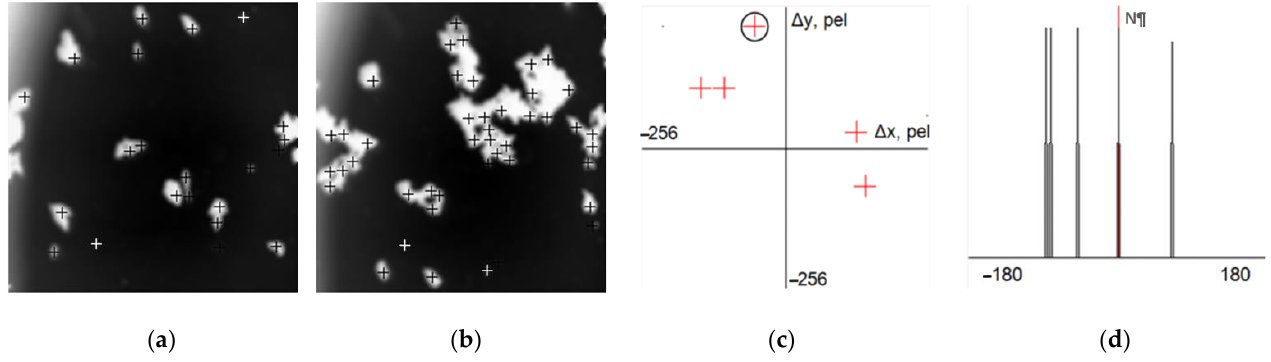
Figure 8. Results obtained by the IMBKPP method for the copper microparticles’ images: ( a , b ) source images with marked particle centres; ( c ) the map of displacement values; ( d ) the histogram of rotation